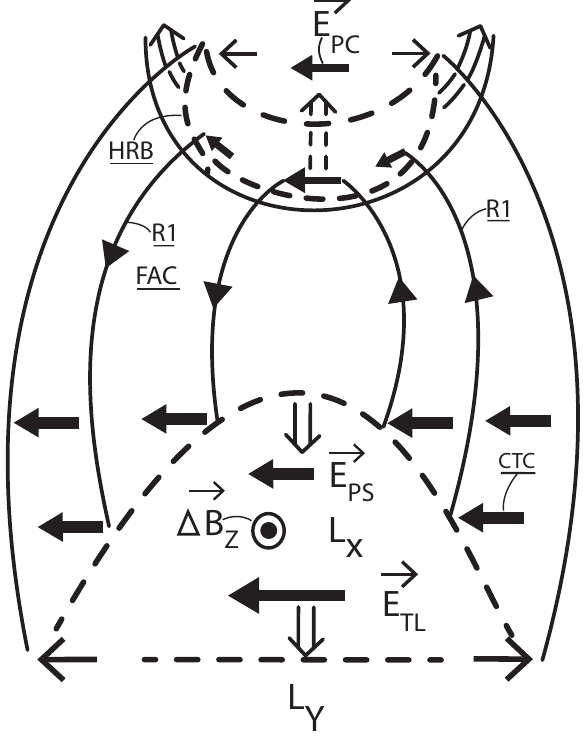
Figure 10. Schematic illustration of PS current disruption and asso- ciated auroral expansion after a major onset ( t 1 ). The geometry of a system of cross-tail currents (CTCs), FACs, and WEJ currents in the ionosphere are indicated at different times during the M–I cou- pling process. Electric fields in the PS ( E PS ) and tail lobes ( E TL ) related to the PS–tail-lobe magnetic field dipolarization ( 1B z /1t ) processes, as well as the PC E field ( E PC ), have been marked. Spa- tial scales of the CD (dipolarization) process are marked L X and L Y